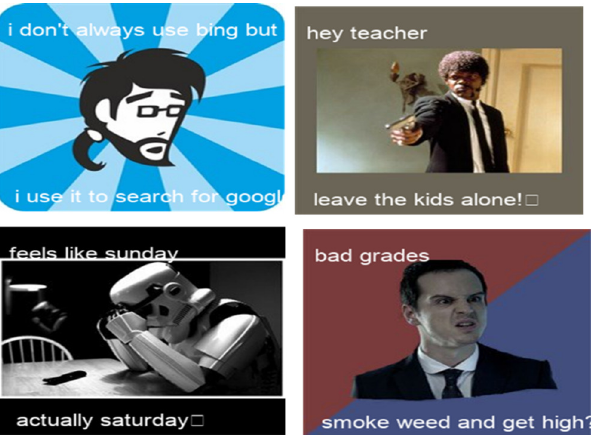
Figure 7. Sample of final generated memes by our proposed method.